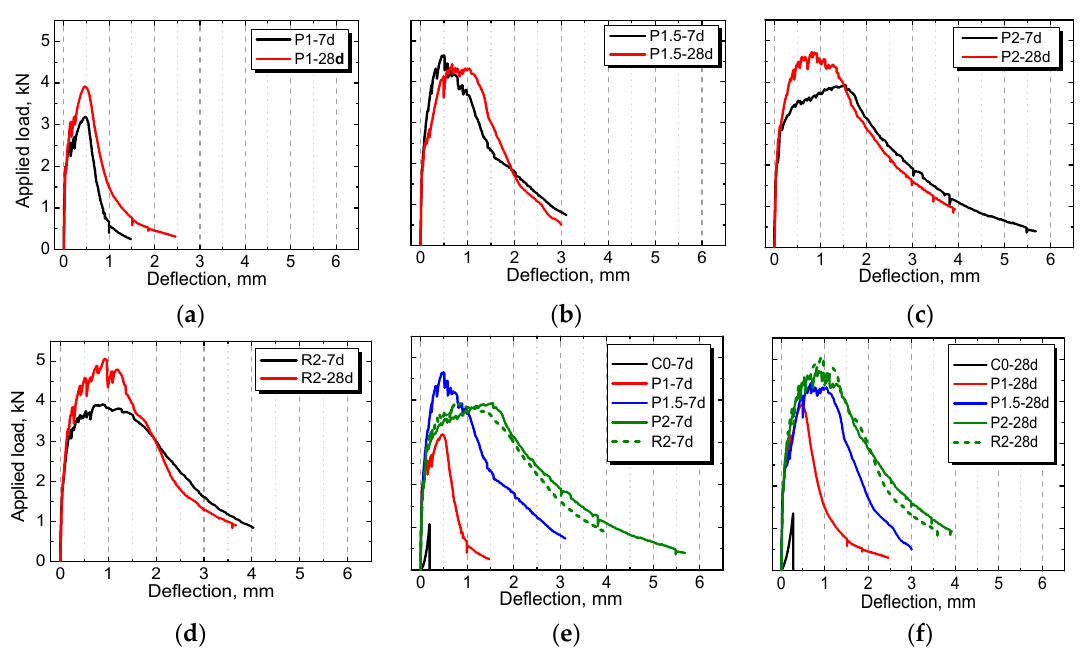
Figure 10. The load–deflection curves of NPFRCCs with different amount of fibers (( a ) P1, ( b ) P1.5, ( c ) P2 and ( d ) R2) and the comparison at ( e ) 7 days and ( f ) 28 days based on the 4-P bending test.